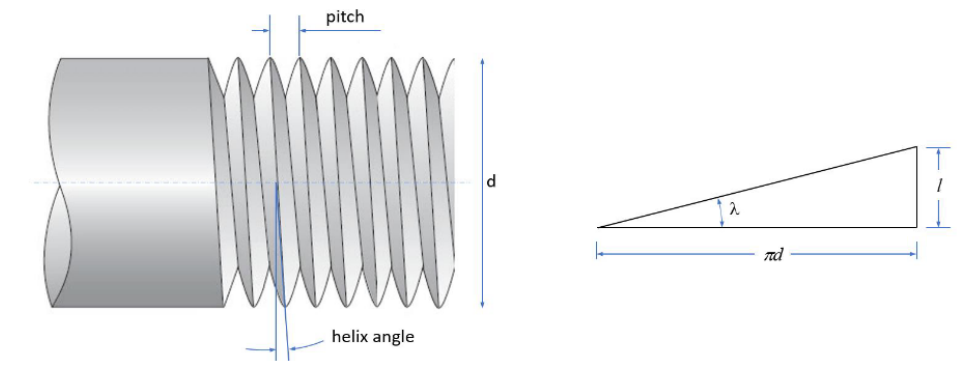
Figure 5. The screw